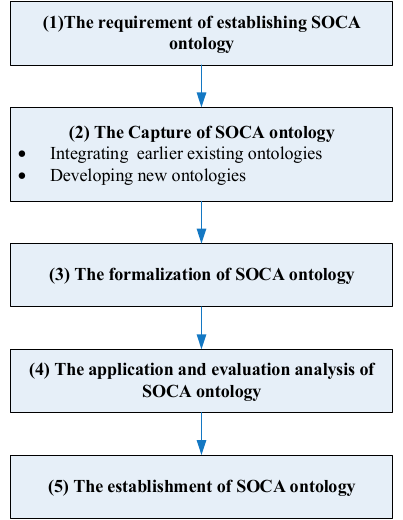
Figure 1. The skeletal methodology for designing SOCA ontology.